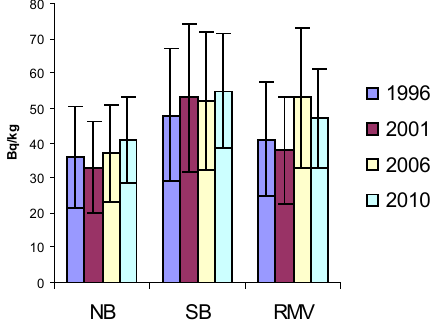
Figure 3 : 226 Ra activity concentration in soil samples from different regions (1996-2010).